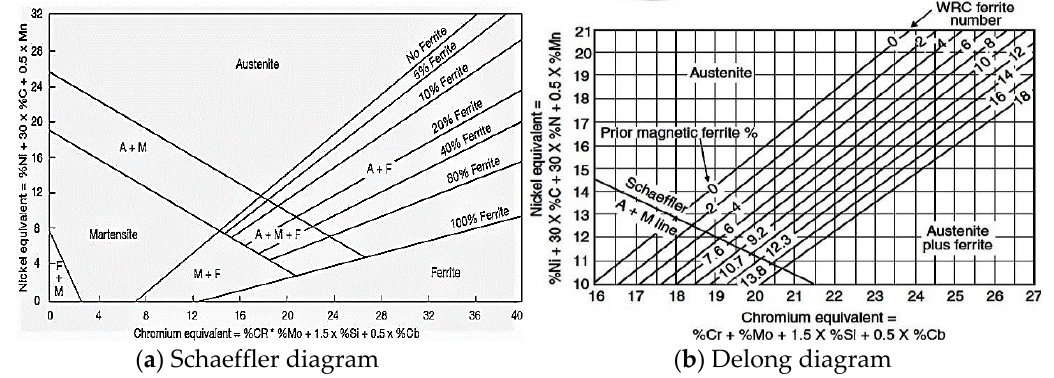
Figure 3. Constitution diagrams to predict phase content in stainless-steel weld metal from chemical composition: ( a) Schaeffler diagram [46]; and ( b) Delong diagram [47].